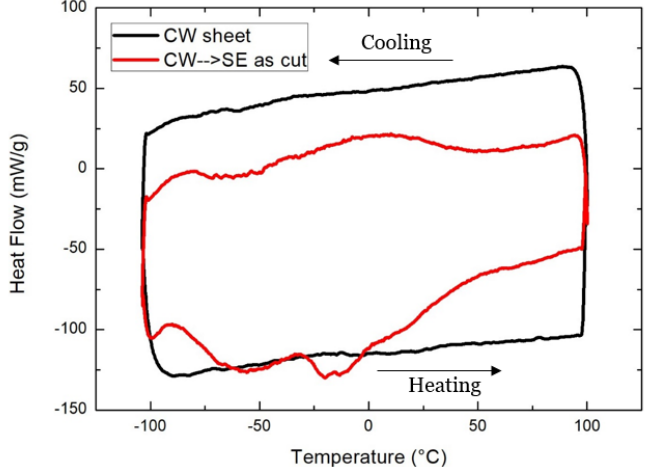
Figure 11. DSC curve of NiTi CW tape and NiTi diamond-like element in as-cut condition.